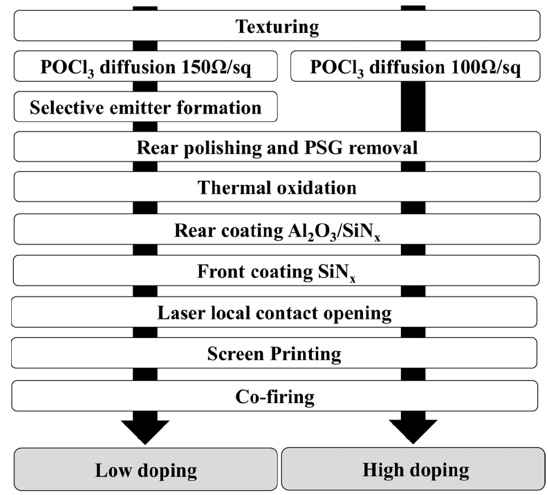
Figure 7. F abrication process for the hot spot test